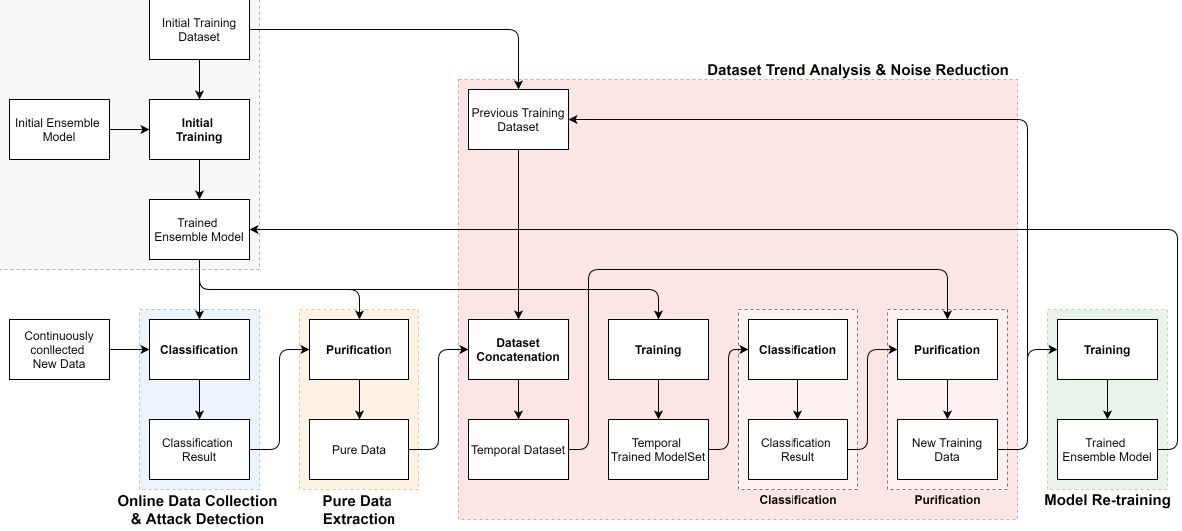
Figure 2. Detailed procedure flow chart for the proposed network attack detection and noise data